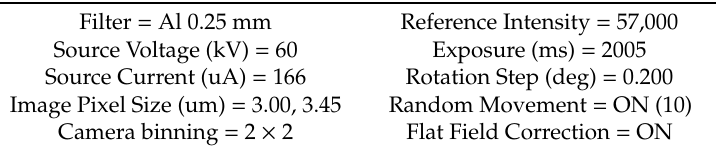
Table 1. micro-CT acquisition settings.